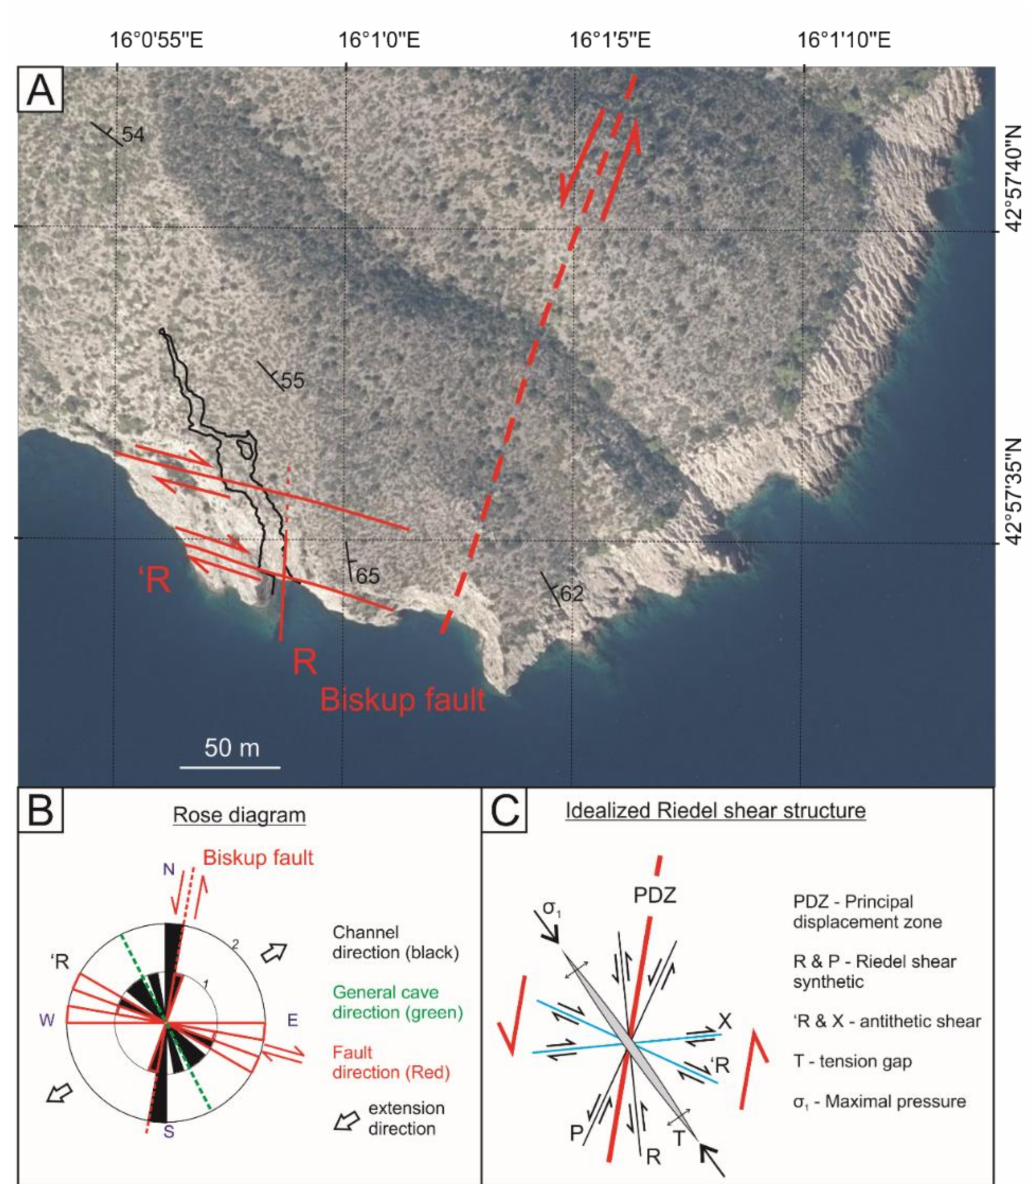
Figure 9. ( A ) Satellite image of the Monk Seal Cave area, with overlapped plan of the cave (black outline). The red lines mark the faults observed on the surface concordant with those measured in the cave (Riedel shear system, R—synthetic, ‘R—antithetic). The black mark indicates strike, dip direction, and dip angle (number) of the bedding (same as in Figure 2). The satellite image was acquired from http://www.arkod.hr/, accessed on 4 July 2021. ( B ) Rose diagram, where black triangles represent the direction of the channels in the cave, and red transparent triangles are the direction of the fault planes inside of the cave. In the diagram, the Biskup fault is also marked with a red dashed line. The green dashed line is the general direction of the cave. ( C ) Schematic idealised Riedel shear structure system according to